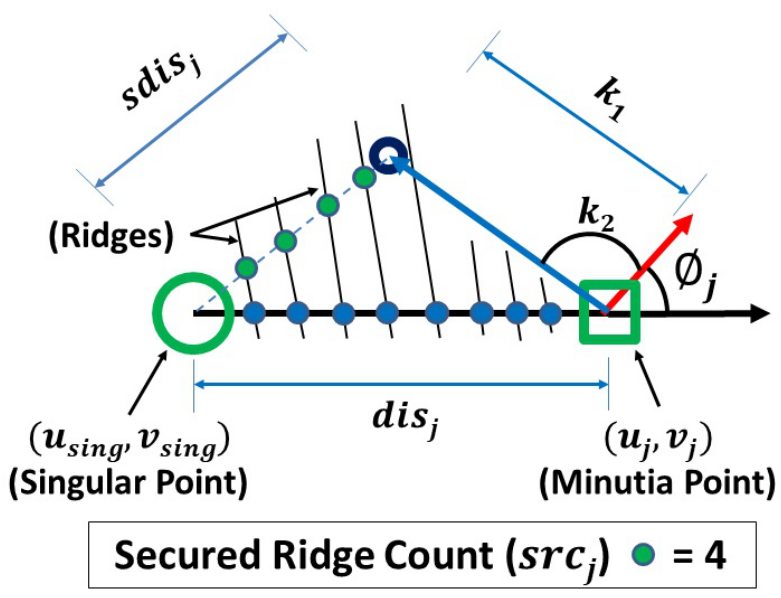
Figure 3. Computation of secured features with the help of user